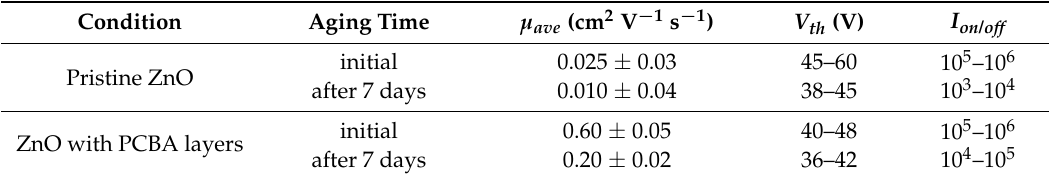
Table 2. The electrical characteristics of the pristine ZnO TFTs and the ZnO TFTs with PCBA interfacial modification layers with Ag electrode.